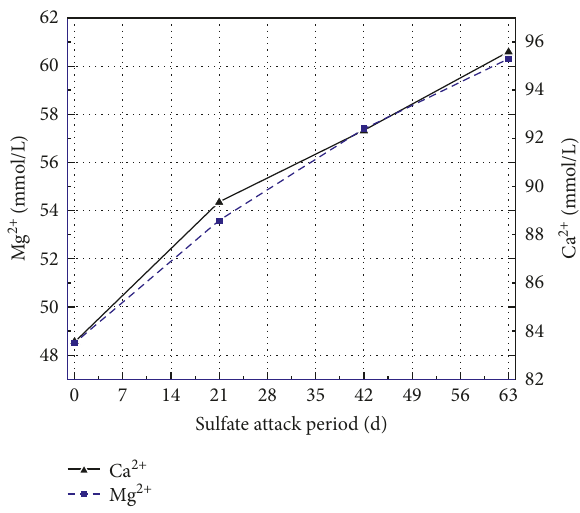
Figure 11: Variation of Ca 2+ and Mg 2+ ion value in concrete exposed to drying-wetting cycles with sulfate